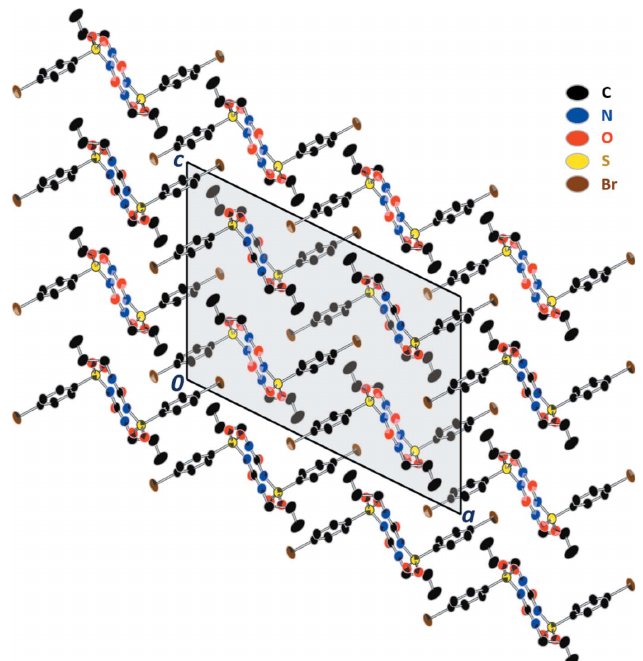
Figure 3 The crystal packing in 4-bromo- N -propylcarbamoyl)benzenesulfonamide viewed along the b axis. Antiparallel stacking of the bromophenyl has a centroid-to-centroid distance of 4.213 A˚ . Displacement ellipsoids are drawn at the 30% probability level. H atoms are not shown for clarity.